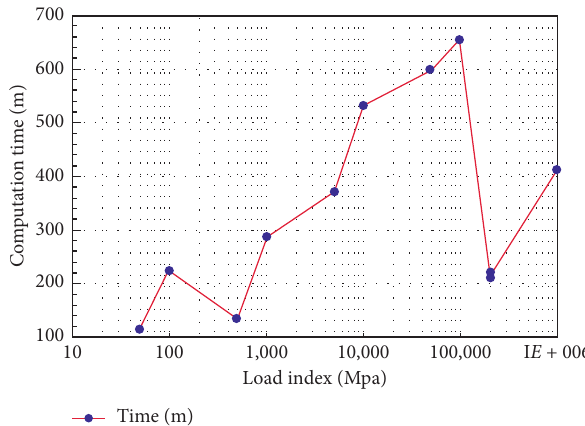
Figure 11: Influence of a penalty factor on the computational